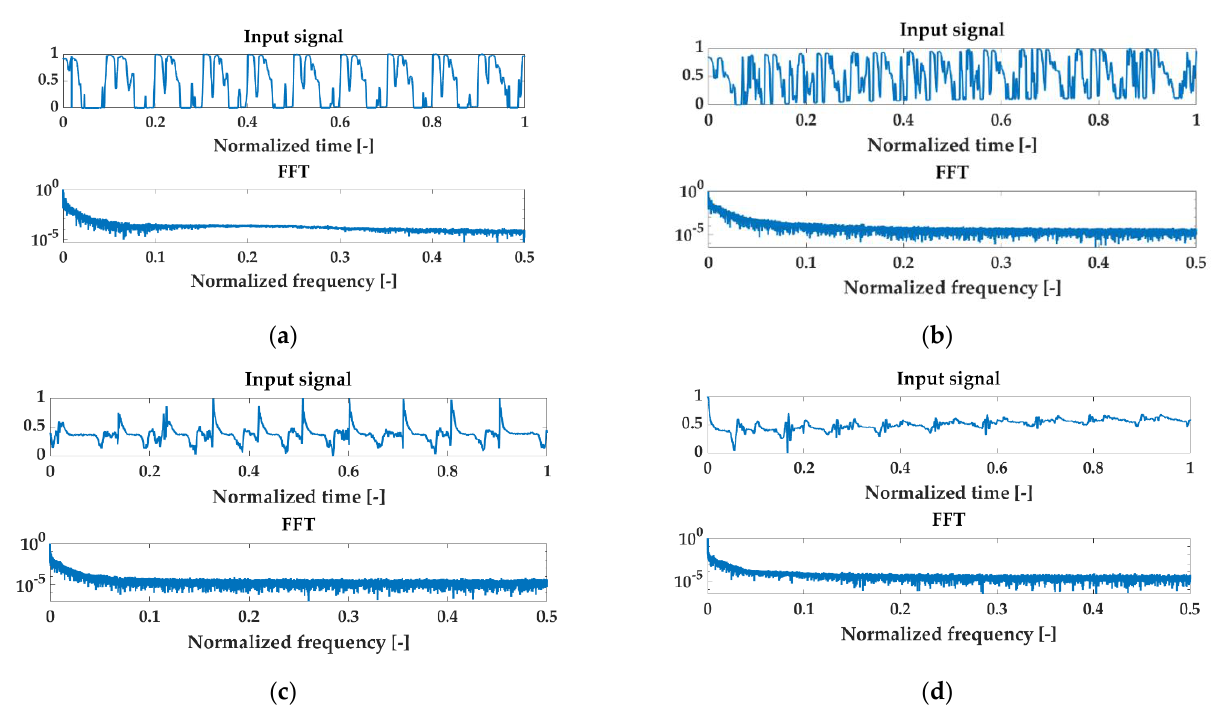
Figure 4. Idea of the measurement system.